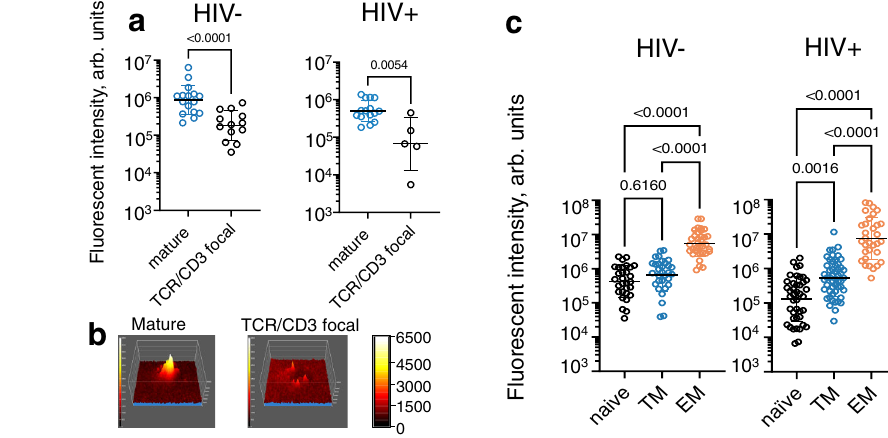
unpaired two-tailed Mann – Whitney test was exploited to determine p values. b Representative surface intensity plots showing naive CD8 T celldegranulation at matureandTCR/CD3focalsynapses.Theplotsaredisplayedinpseudo-colorscale. c Quantitation of CD107a accumulation at the interface of naive, TM and EM CD8 TcellsfromHIV-anduntreatedHIV+individuals.EachcirclerepresentsindividualT cell,HIV − : n =30(naive),31(TM),34(EM)andHIV+: n =42(naive),52(TM),32(EM) cells.Geometricmeansareindicatedbyblacklines,errorbarsrepresentSDfactors. P values are determined by nonparametric unpaired Kruskal – Wallis test with Dunn ’ stestformultiplecomparison. a – c Representativeresultsofoneoutofthree (untreated HIV+ donors) and one out of two (HIV − donors) independent experi- ments are shown. Source data are provided as a source data fi